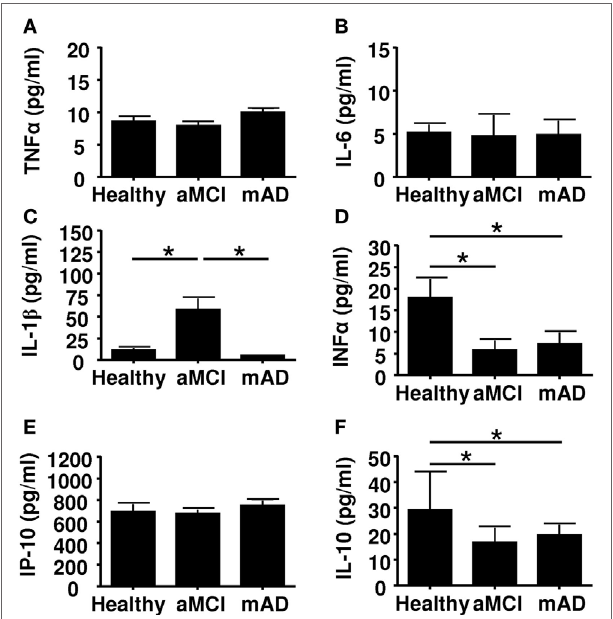
FigUre 5 | Quantification of cytokine concentrations in sera of healthy, amnestic mild cognitive impairment (aMCI), and mild AD (mAD) subjects. (a) TNF α . (B) IL-6. (c) IL-1 β . (D) Il-10. (e) IP-10. (F) IFN α . Each group was composed of at least 10 independent subjects with determinations made in triplicate. Cytokine quantification was done using the Luminex technology. Data are shown as the mean ± SEM. The asterisks (*) correspond to p <